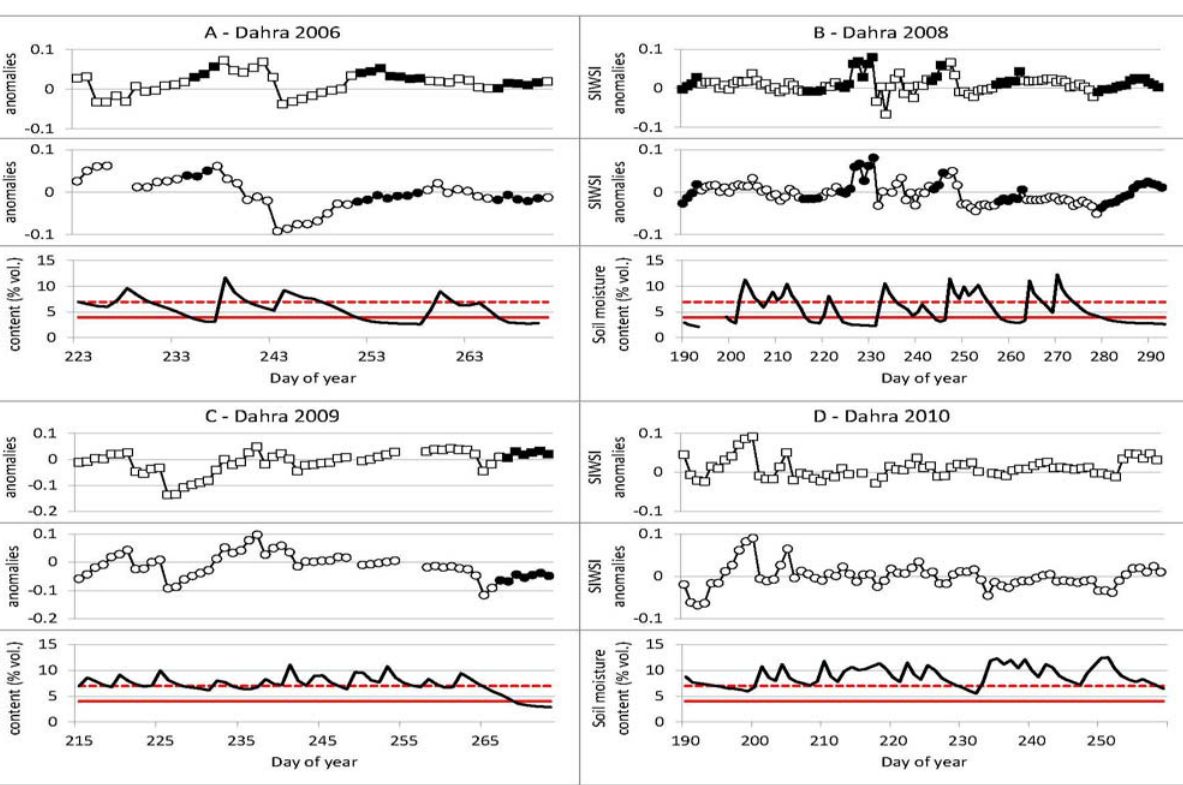
Figure 5. Shortwave Infrared Water Stress Index (SIWSI) anomalies and soil moisture: Top pane: SIWSI anomalies from savitsky-golay detrending. Middle pane: SIWSI anomalies from 2nd order detrending (solid dots: SIWSI anomalies during Soil Moisture Content (SMC) < Wilting point ( WP) + 1. Hollow dots: SMC > WP + 1). Bottom pane: Dark grey line: SMC. Red line: WP+ 1 (vol.%). Red dashed line: Field capacity (except at Demokeya, here it represents 8